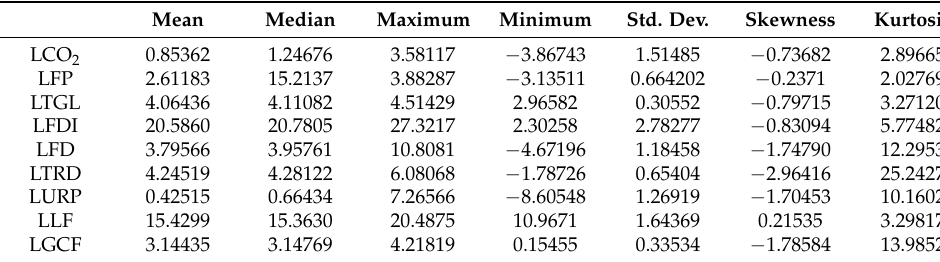
Table 3. Descriptive statistics.